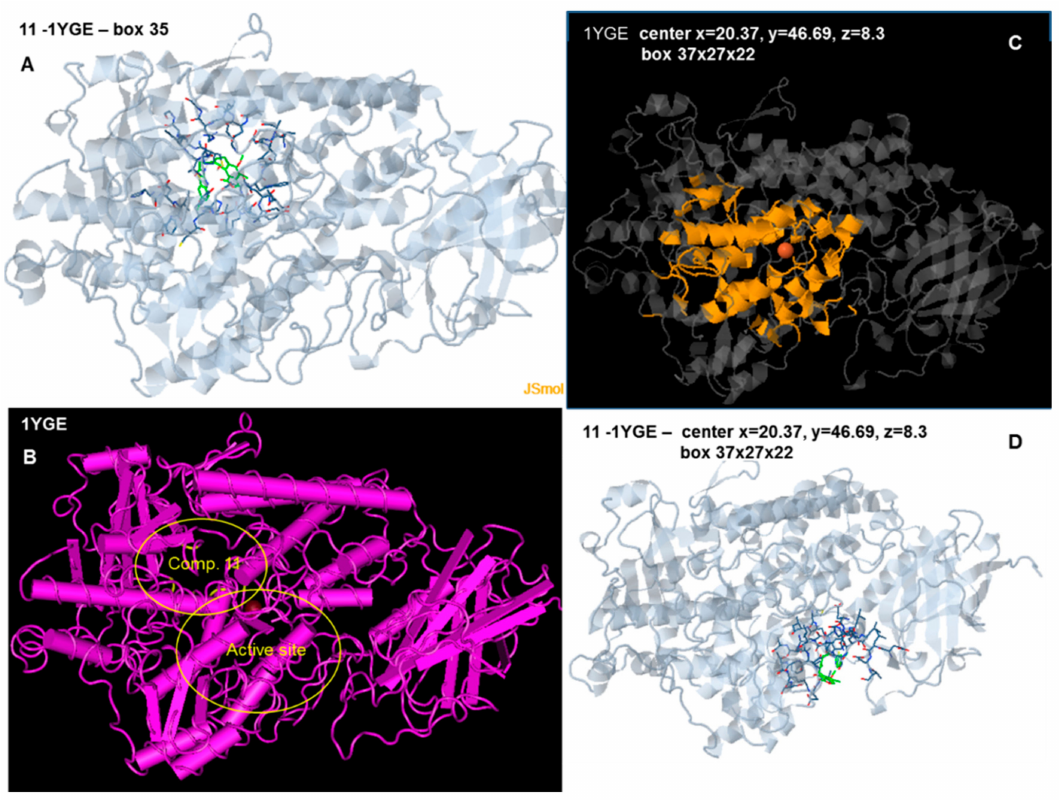
Figure 9. ( A , B ) Docking of compound 11 to the soybean LOX-1 structure 1YGE, target center: x = 26.37 Å, y = 42.69 Å, z = 12.36 Å, target box 35 × 35 × 35Å. The target box enables the compound to dock preferentially at the upper left corner, behind the active site. The interacting amino acids are marked in yellow at Figure 7B; ( C ) Structure 1YGE with the target box in yellow (center x = 20.37 Å, y = 46.69 Å, z = 8.3 Å, box 37 × 27 × 22 Å); ( D ) Docking of compound 11 to 1YGE (center x = 20.37 Å, y = 46.69 Å, z = 8.3 Å, box 37 × 27 × 22